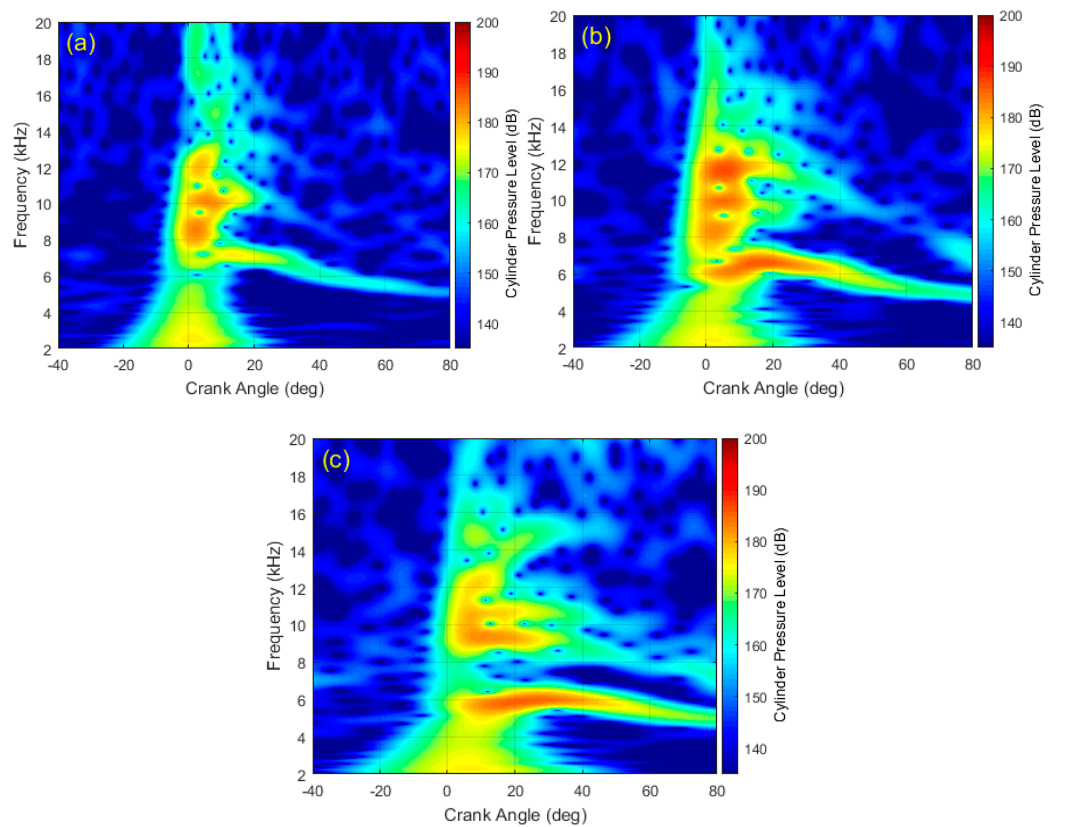
Figure 16. Time-frequency distribution (TFD) at different engine speeds: ( a ) 1200; ( b ) 1600; ( c ) 2000 r/min.